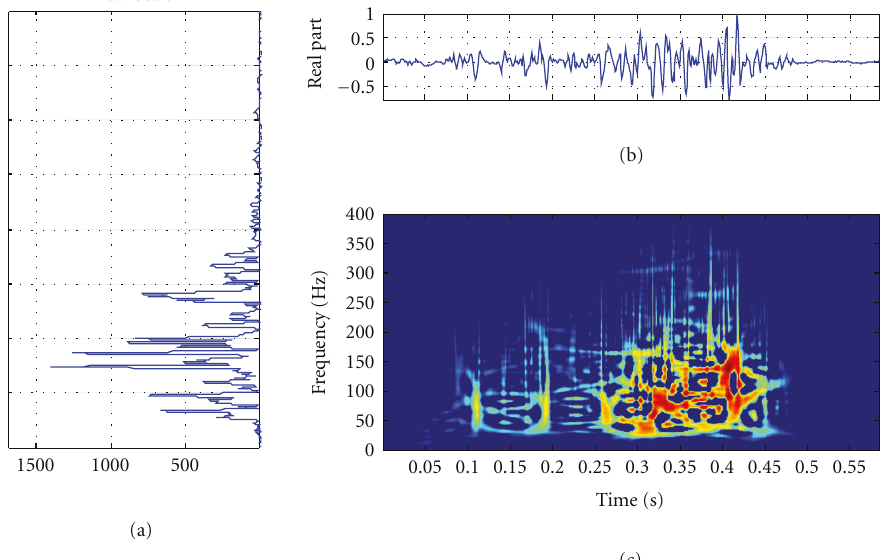
Figure 7: The (a) power spectral density, (b) time-domain waveform, (c) time-frequency visualization (d) energy peak of subject 001 walk 4 S 3 , over a single activation of the